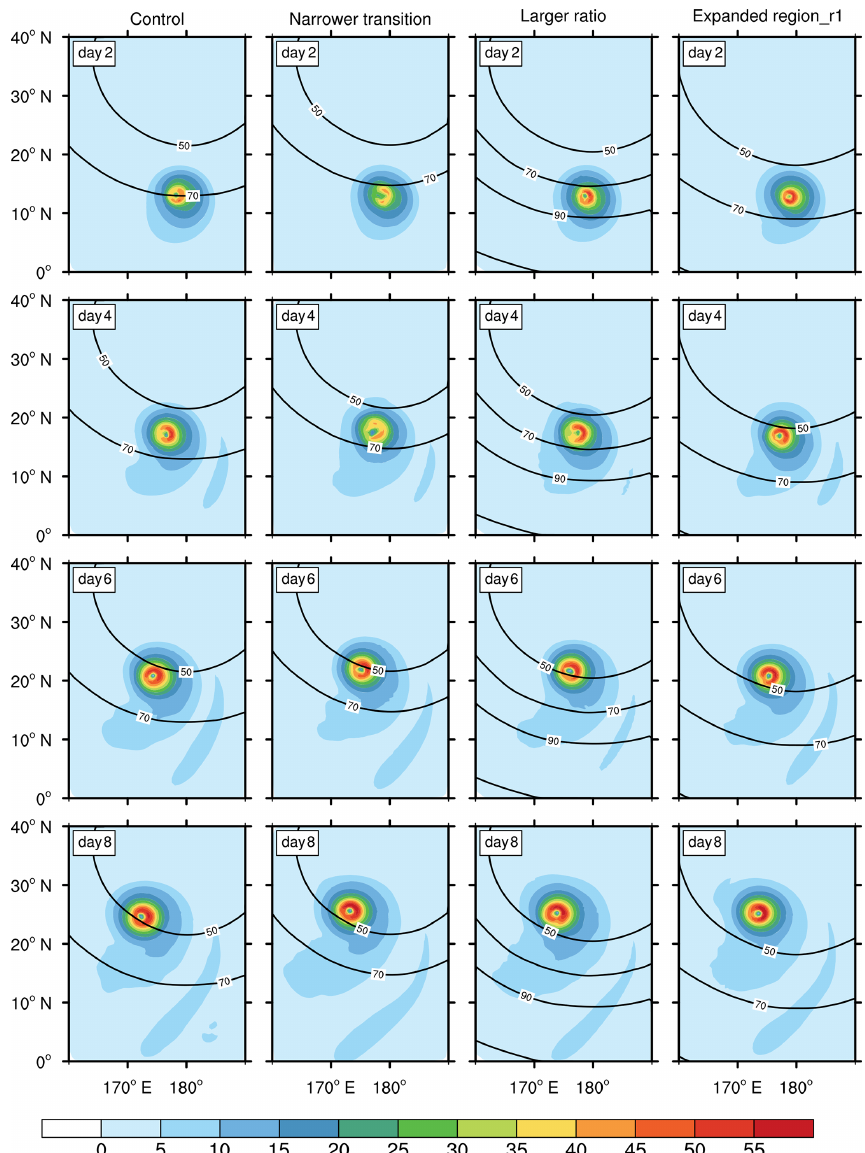
Figure 10. Corresponding to the four cases shown in Fig. 9, the simulation results on days 2, 4, 6, and 8 are shown to examine the movement of the tropical cyclones when they cross the mesh